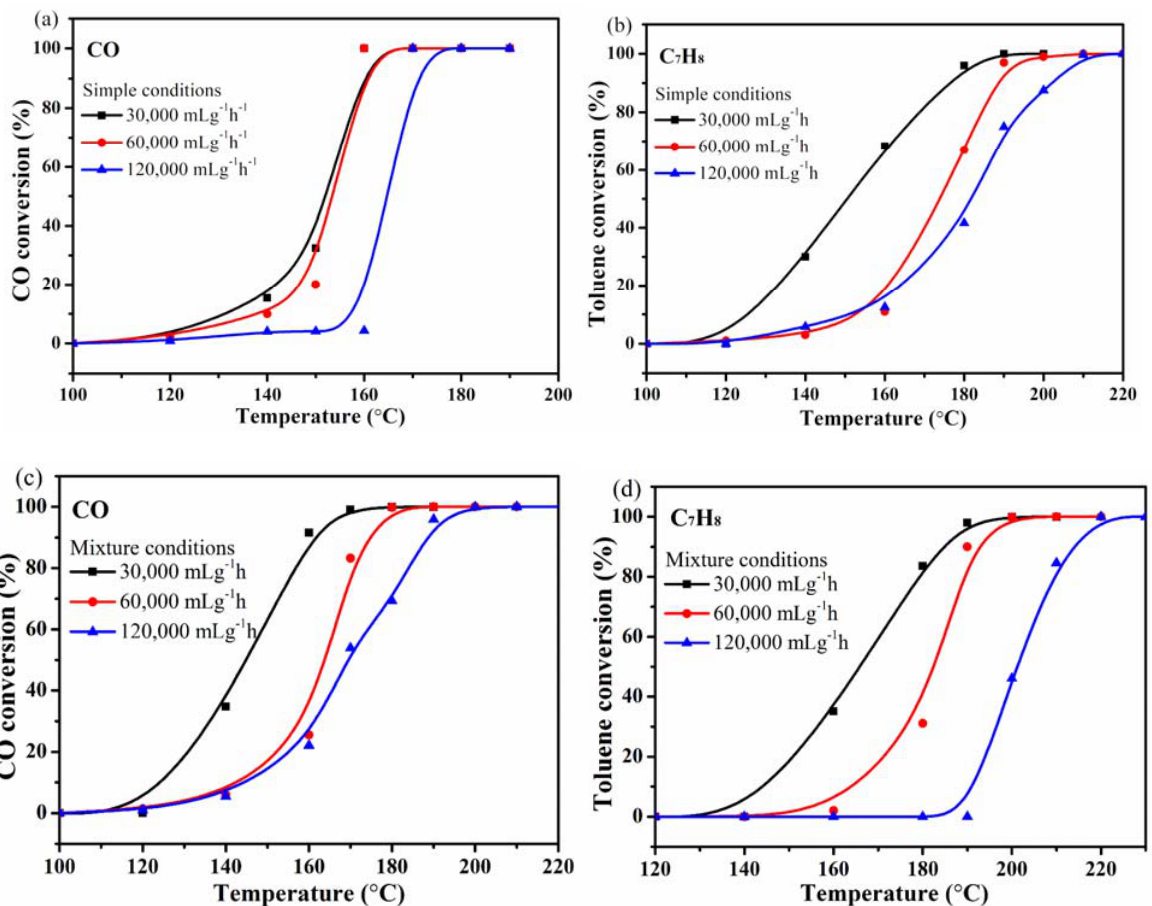
Figure 8. ( a ) CO and ( b ) toluene conversions in simple conditions, ( c ) CO and ( d ) toluene conversions in mixture conditions over the Pt ‐ Co/Al 2 O 3 catalyst under different WHSV.